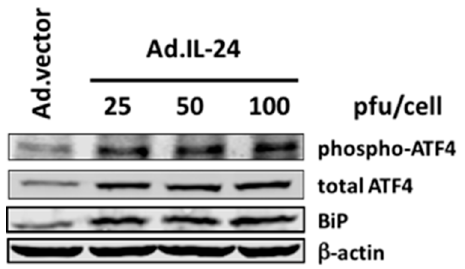
Figure 1. IL-24 activates ATF4 in a dosage dependent manner. MCF-7 cells were treated for 72 h with Ad.IL-24 (25, 50, and 100 plaque-forming units (pfu) per cell) or Ad.vector (100 pfu per cell). Cells were collected, protein purified, and subjected to Western blot analysis to detect phospho-ATF4, total ATF4, BiP, and β -actin.